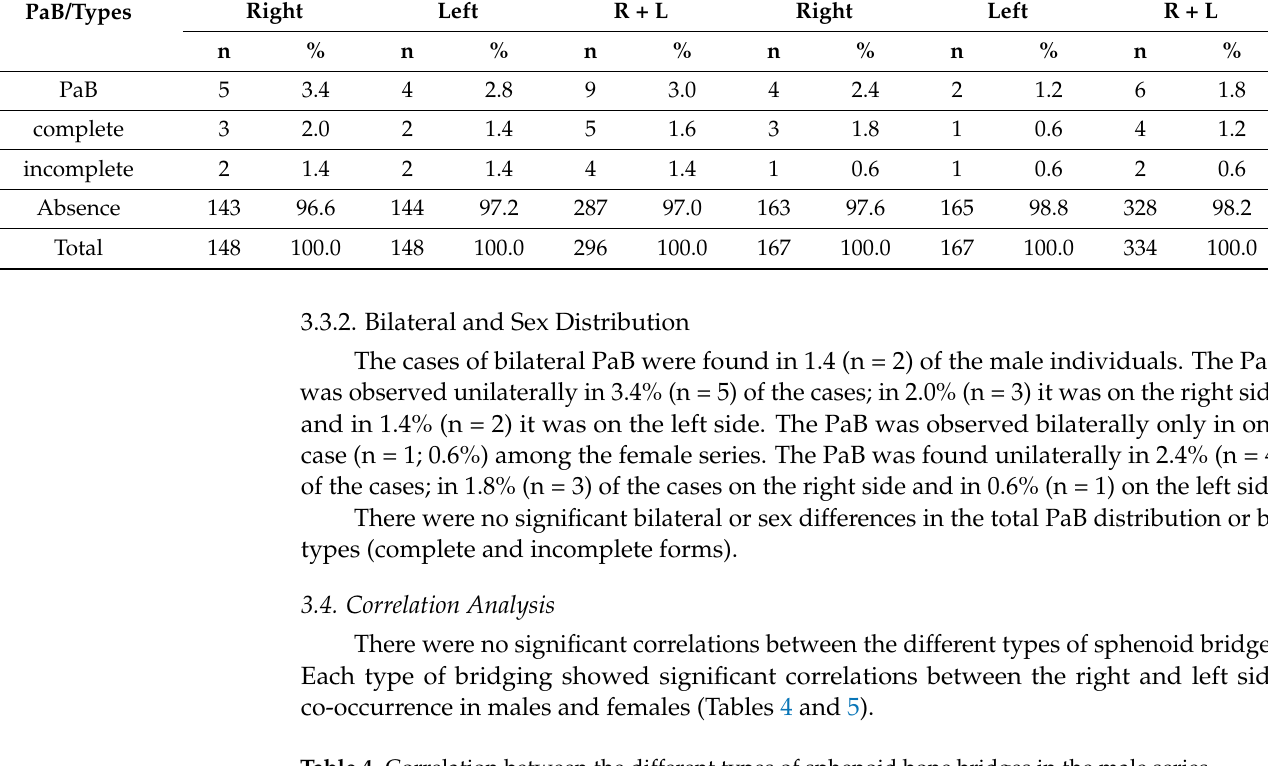
Table 4. Correlation between the different types of sphenoid bone bridges in the male